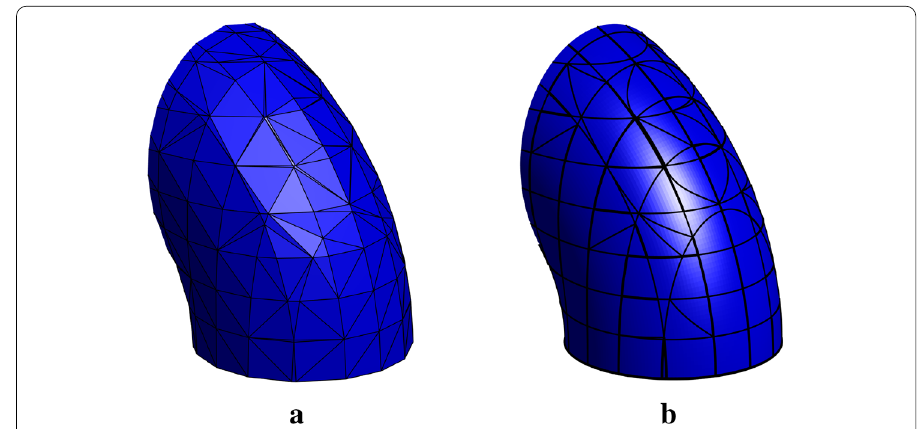
Fig. 5 Surface segments of a regular torus in cgFEM using the same approximation mesh. a Linear facets, b NURBS surface